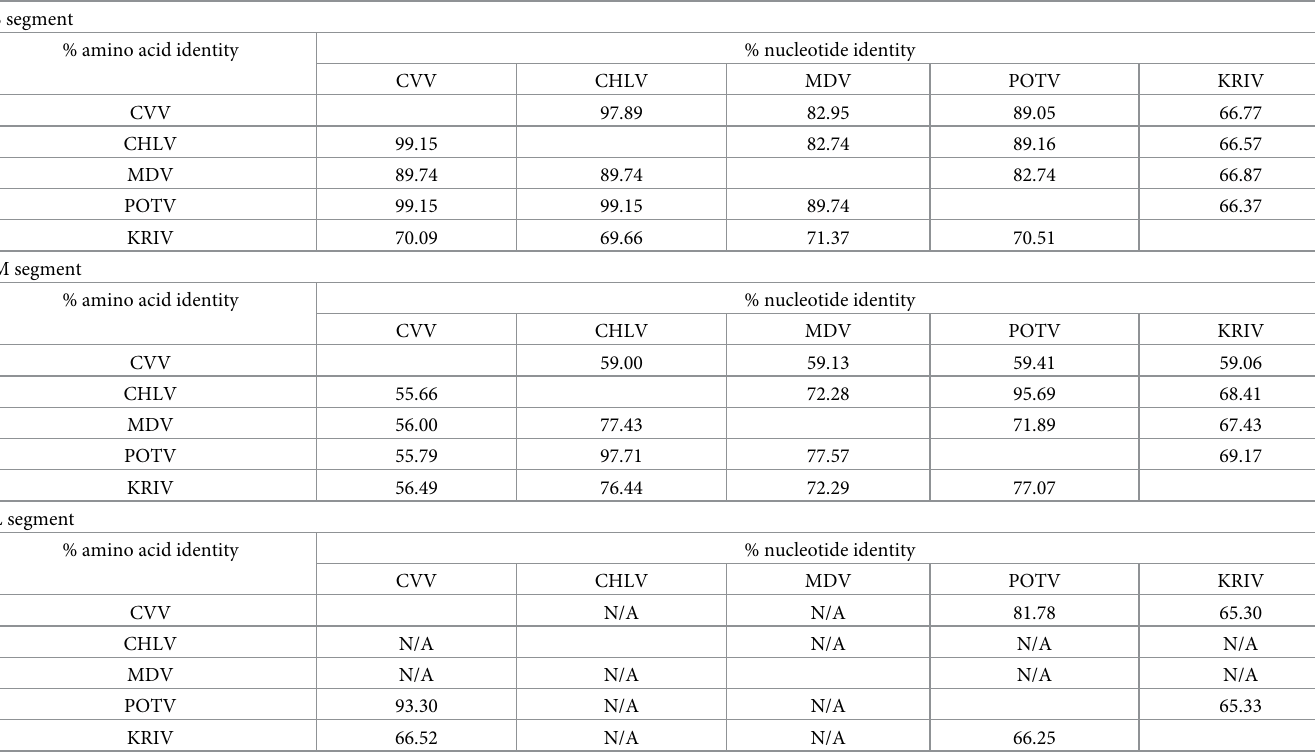
Table 3. Amino acid and nucleotide sequence identity comparisons across entire S, M, and L segments of selected orthobunyaviruses.